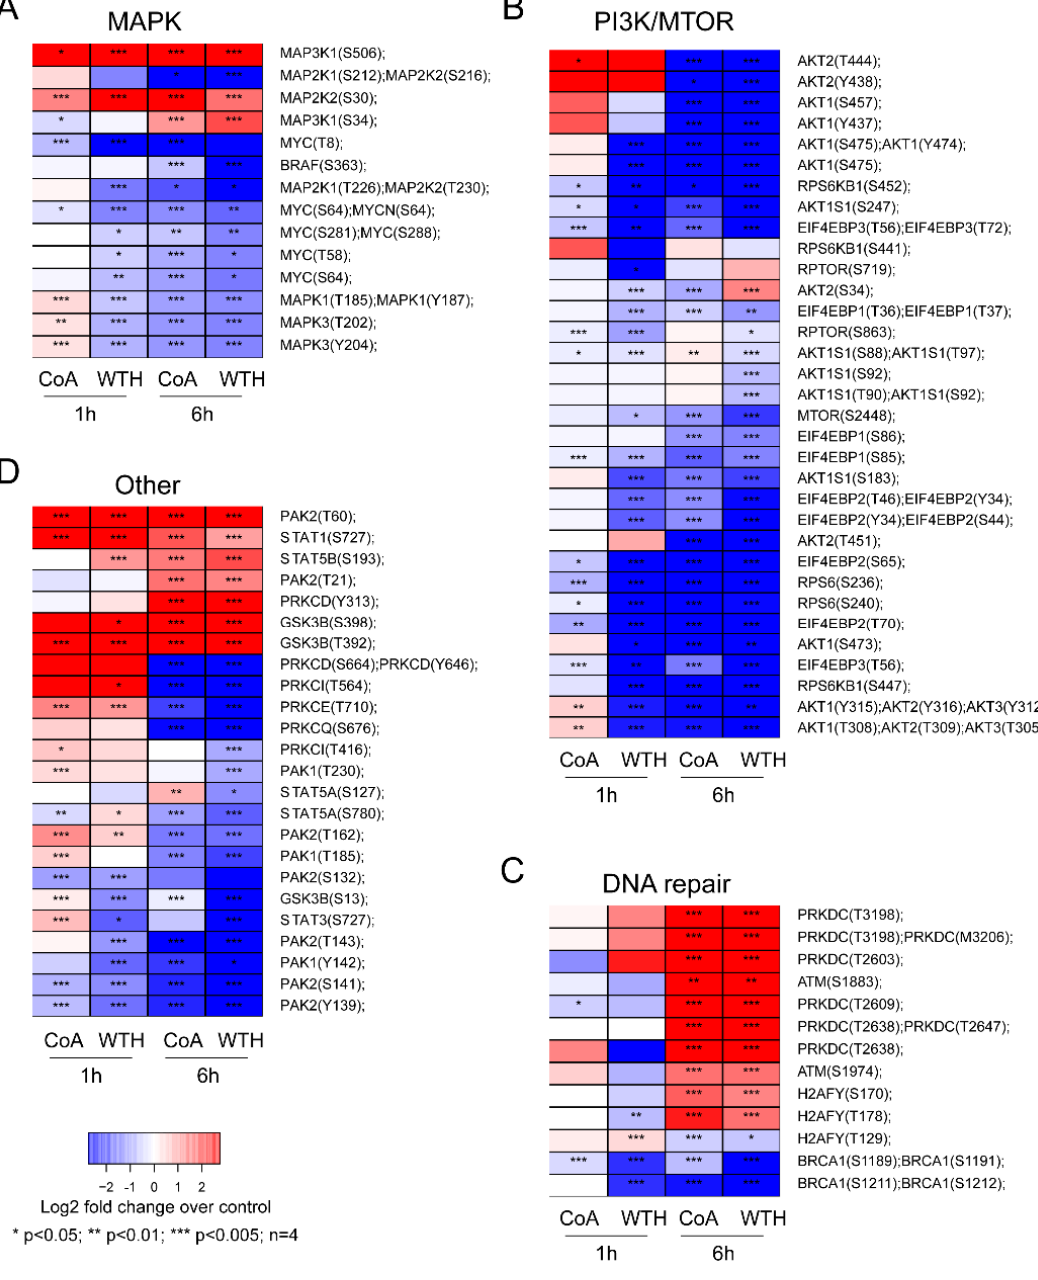
Figure 6. The withanolides induce pleiotropic effects in the phosphorylation of pro-survival signaling proteins. Shown are changes in phosphorylation sites in mitogen-activated protein kinase (MAPK) ( A ), phosphatidylinositol 3-kinase/ mammalian target of rapamycin (PI3K/MTOR) ( B ), DNA repair ( C ) and other signaling pathways ( D ) induced by withanolide treatment at the indicated time points. p -values were calculated by t -test ( n = 4).